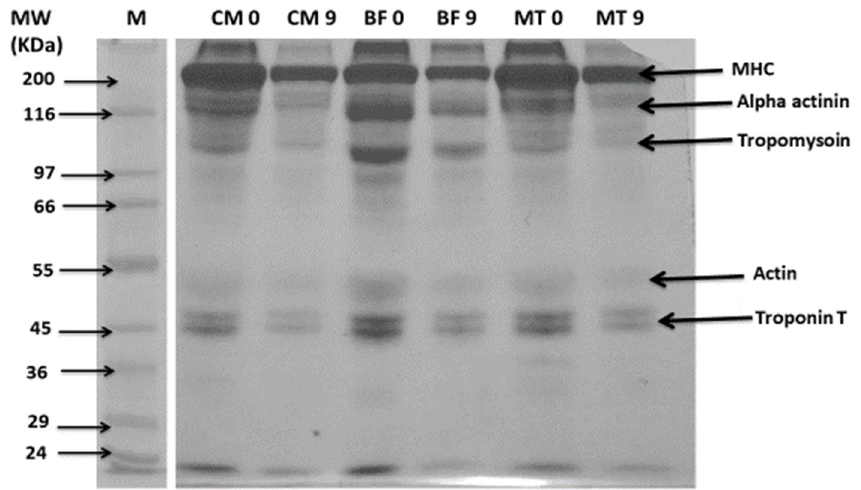
Figure 2. Sodium dodecyl sulphate polyacrylamide gel electrophoresis (SDS-PAGE) pattern of proteins extracted from camel meat, beef and mutton on day 0 and day 9 of refrigerated storage. Notes: CM 0 and CM 9; BF 0 and BF 9; and MT 0 and MT 9 denotes camel meat, beef and mutton on day 0 and on day 9 of storage, respectively.